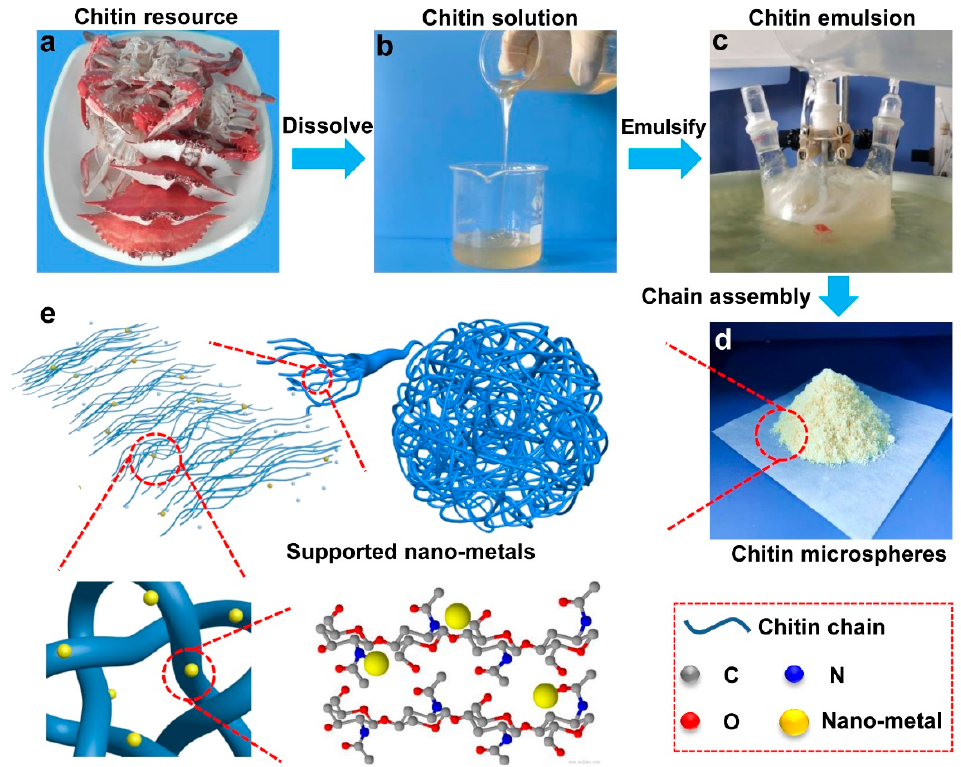
Figure 1. Schematic diagram of the formation process for the chitin supported nano-metal catalyst: The chitin resource (a). The chitin solution (b). The chitin emulsion (c). The chitin microspheres (d). The chitin microspheres supported nano-metals (e).